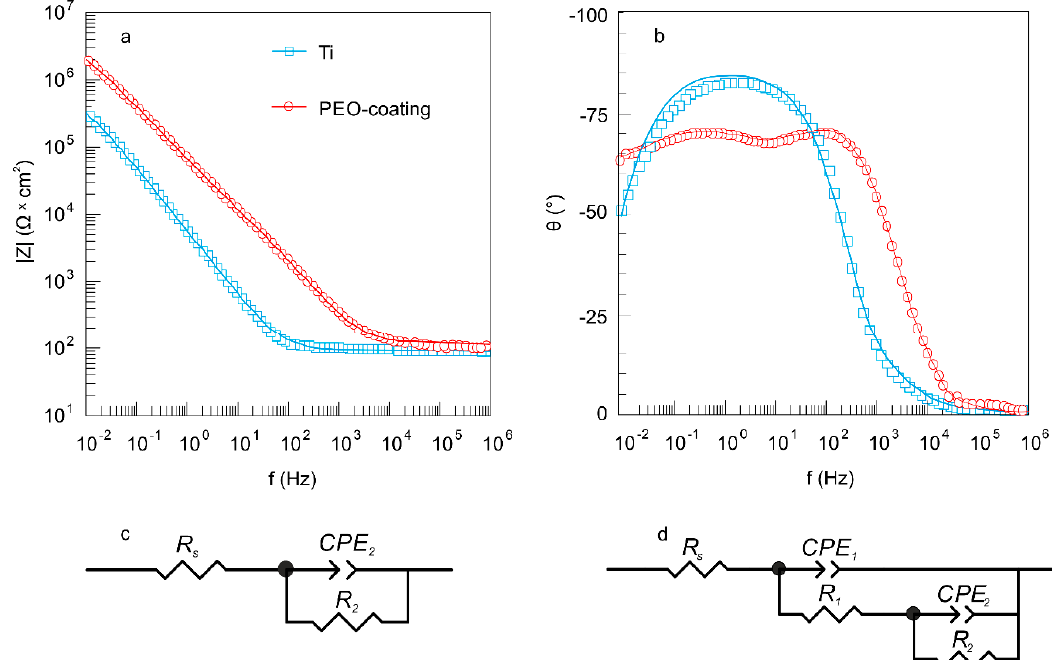
Figure 7. Bode plots (dependence of ( a ) impedance modulus | Z | and ( b ) phase angle θ on frequency f) for uncoated sample and sample with a PEO-coating and equivalent electrical circuits used to fit the experimental impedance spectra: ( c ) one–R–CPE–circuit, ( d ) two–R–CPE–circuit. Impedance spectra contain experimental data (scatter plot marked by symbols) and theoretical fitting curves (lines), which simulate the experimental results by means of equivalent electrical circuits. Test liquid is MEM.